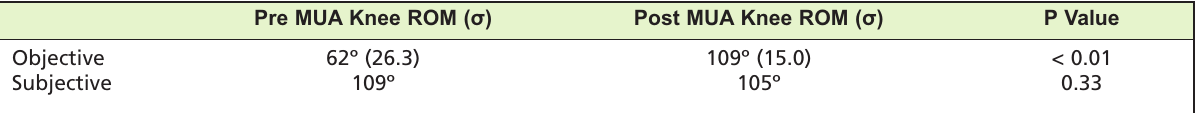
Comparison of RRom Pre and Post Table IV: